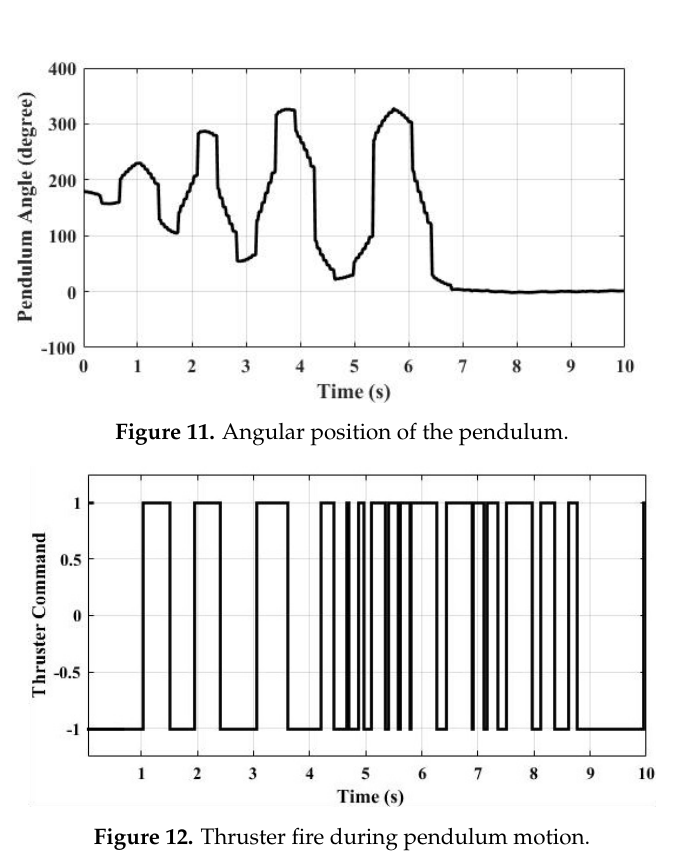
Figure 12. Thruster fire during pendulum